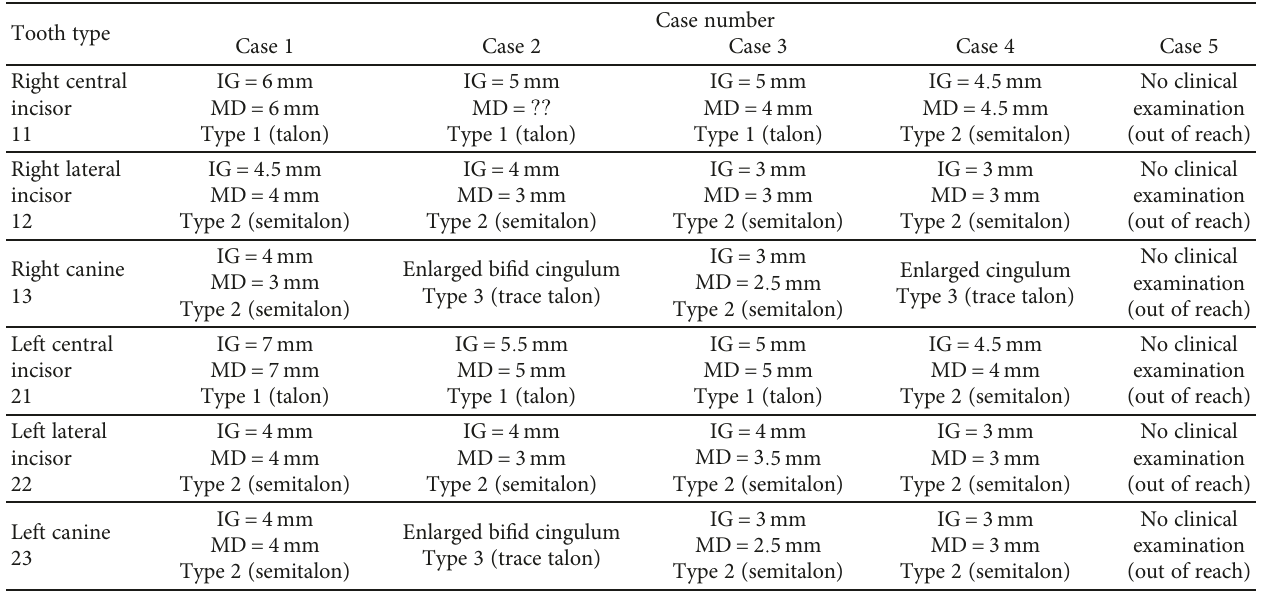
Table 1: Comparison between measurements of talon cusps of the fi ve cases and Hattab et al. ’ s classi fi cation for each tubercle.